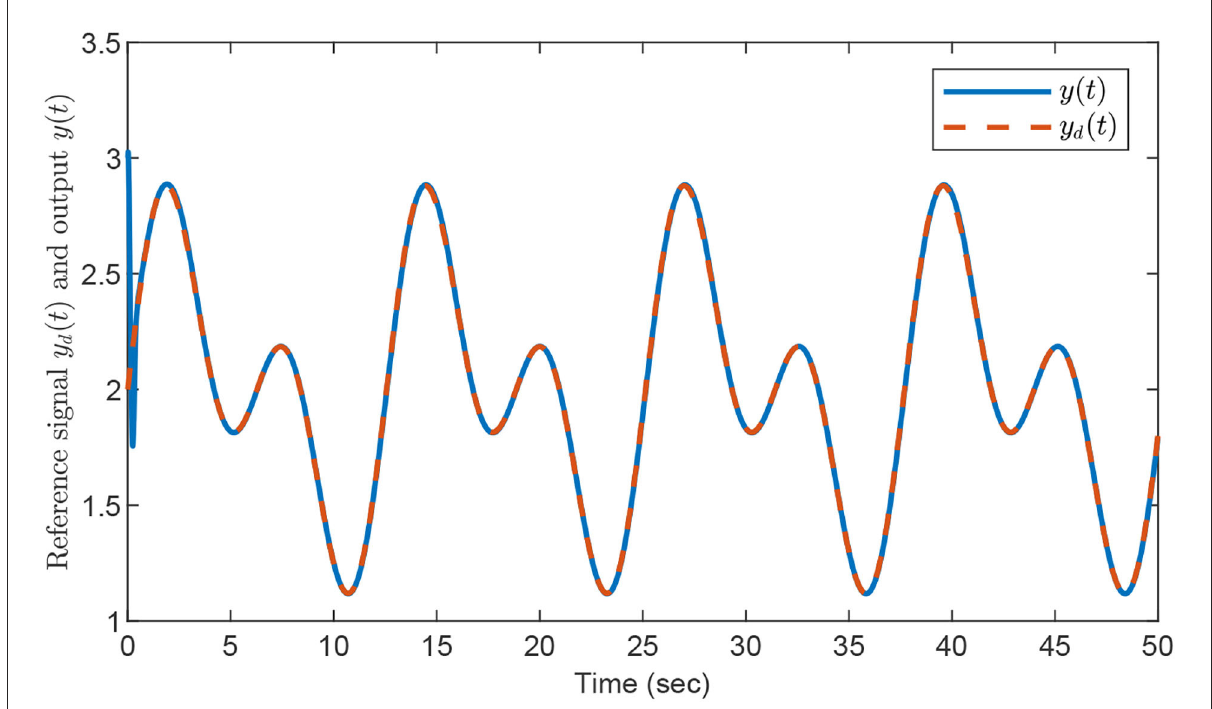
FIGURE2 Tracking performance of the output y with respect to the reference signal y d .